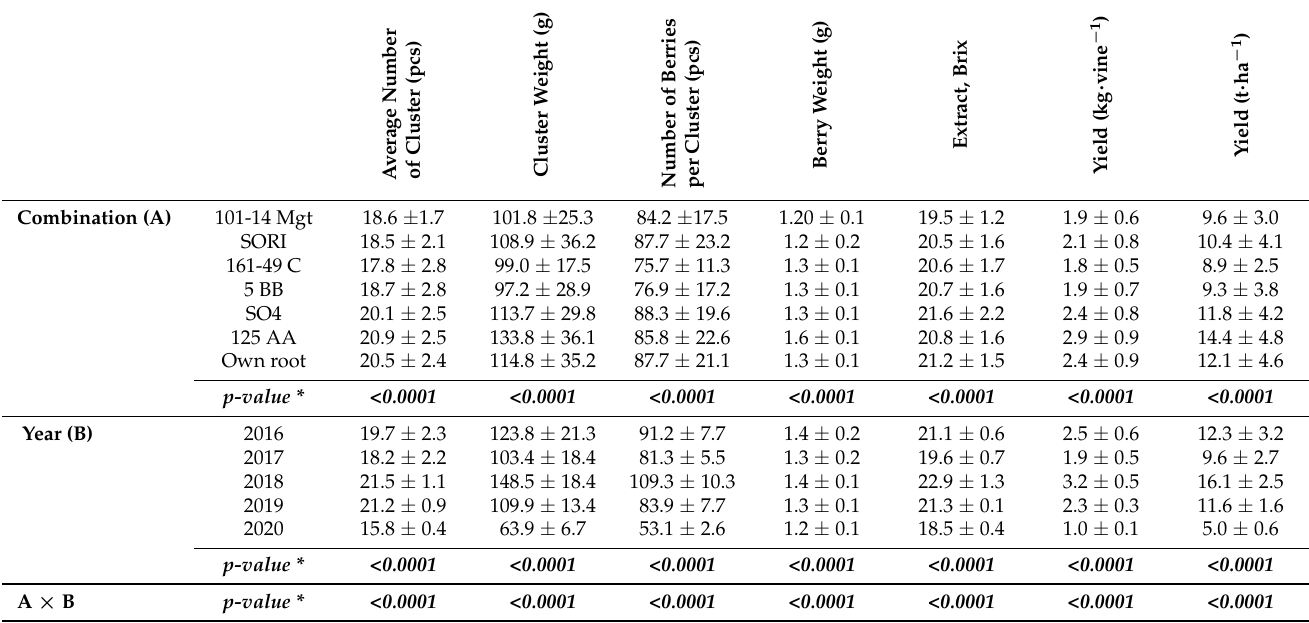
Table 2. Effect of rootstock on size and properties of yield of grapevine Regent cultivar in